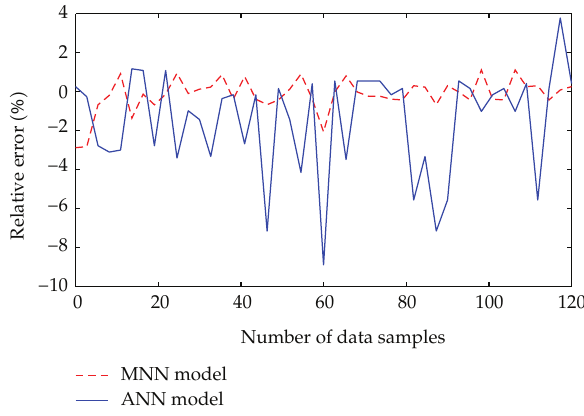
Figure 10: Relative error curve of